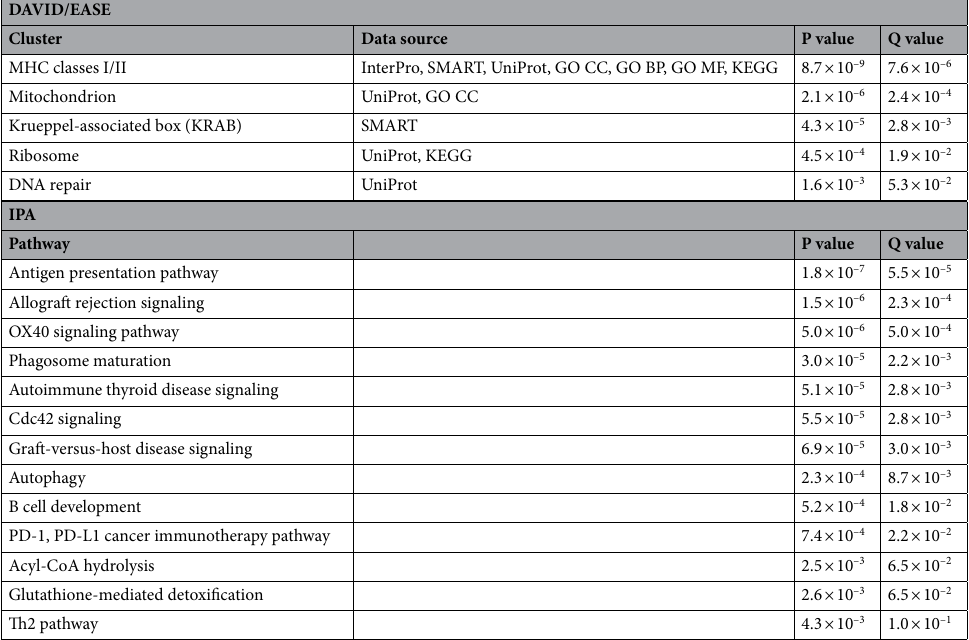
Table 1. Pathway enrichment of liver specificity of genes with